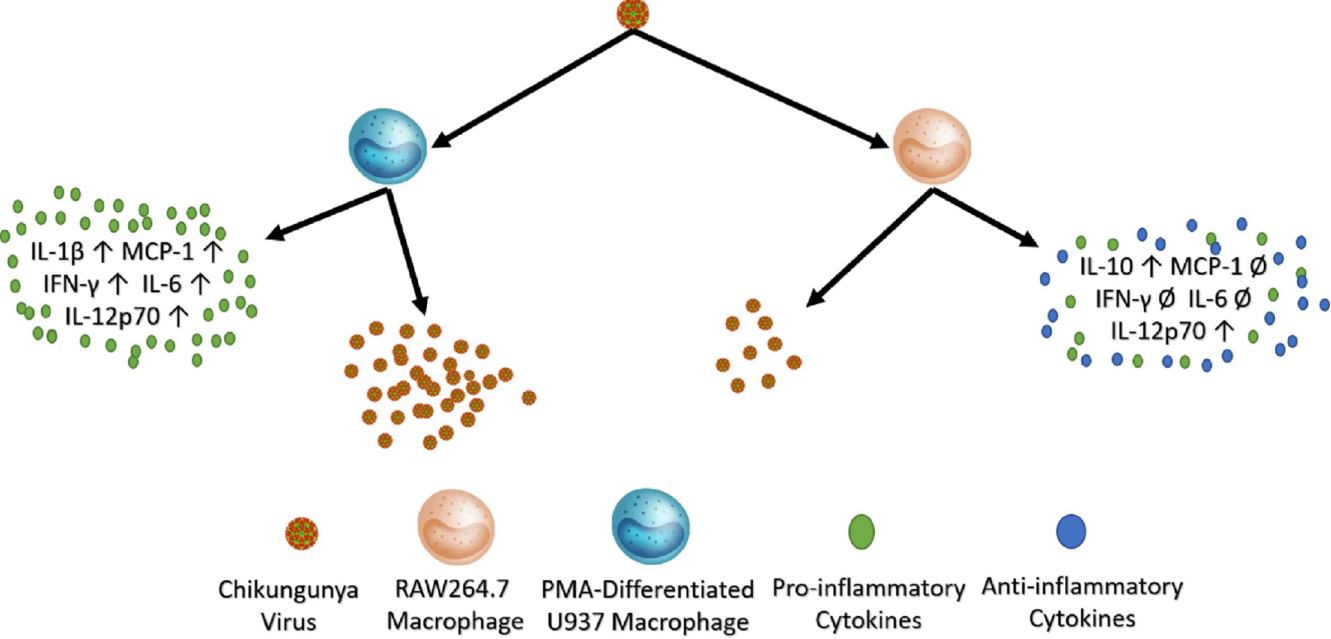
Fig 10. A graphic summary of CHIKV infection in human PMA-differentiated U937 macrophages and murine RAW264.7 macrophages. CHIKV infection in PMA- differentiated U937 macrophages produces higher amounts of virions and induces a more vigorous pro-inflammatory cytokine response. CHIKV infection in RAW264.7 cells results in lower quantities of virions and induction of more anti-inflammatory cytokines.